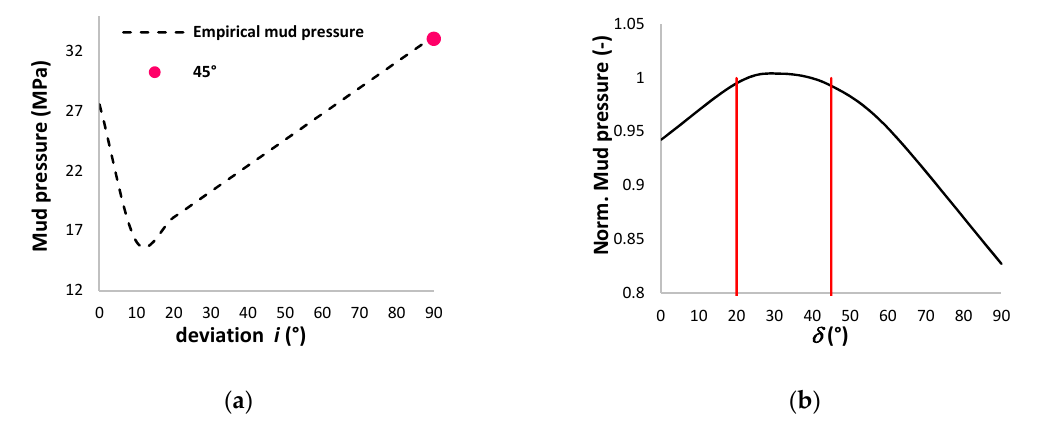
Table 4. Data used for the calculation of mud pressures at the Pedernales Field, Venezuela [5].